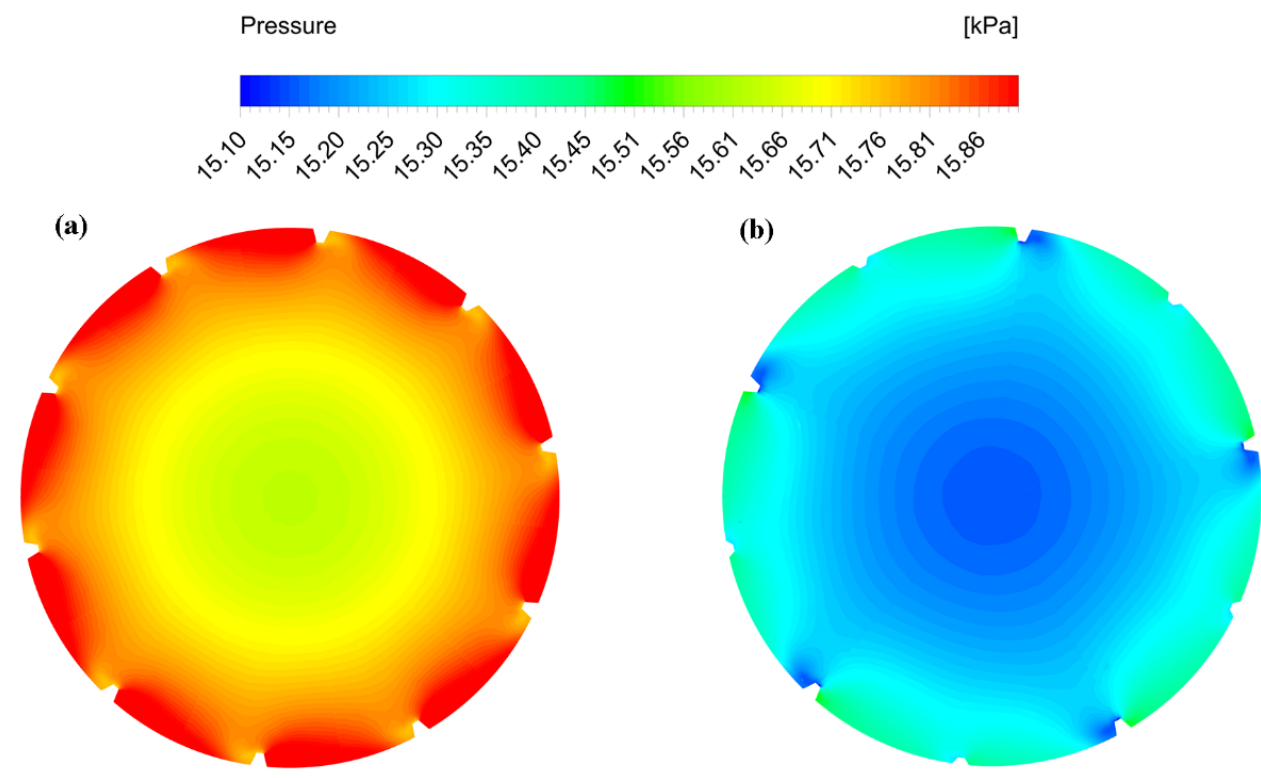
Figure 9. Turbulence kinetic energy contours at Re 54,000 for ( a ) Equal fin height; ( b ) Alternating fin height.